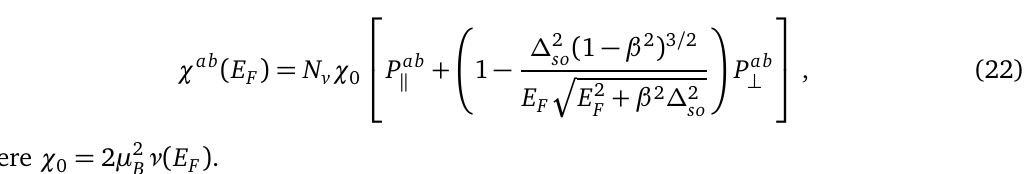
Figure 3: (Color online) Schematic diagram of the spin-orientation axis d makes an angle θ from the z -axis in monolayer WTe s